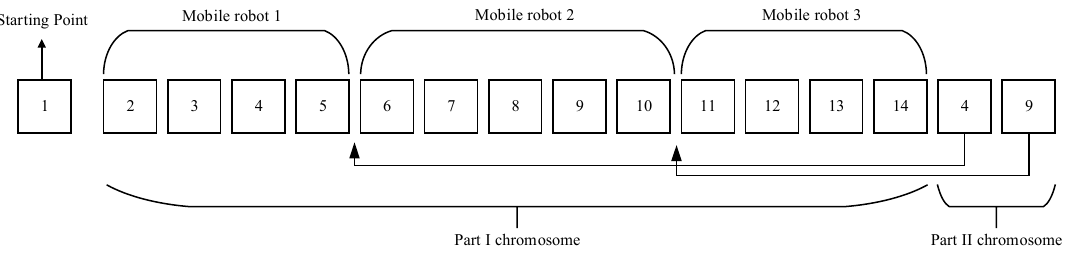
Figure 3. Coding representation of m = 14, n = 3.